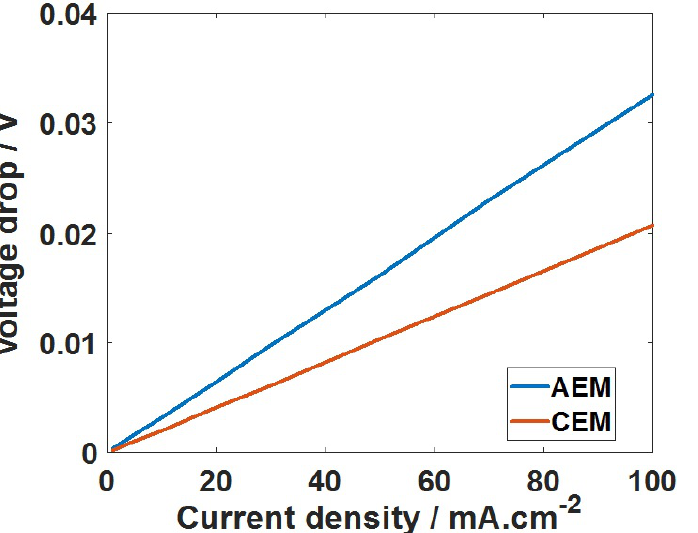
Figure 8. The potential drop across the CEM and AEM, respectively, at the current density up to 100 mA · cm − 2 . The potential ( φ = 0) on the anolyte side of the membrane for CEM and catholyte side of the membrane for AEM is fixed to